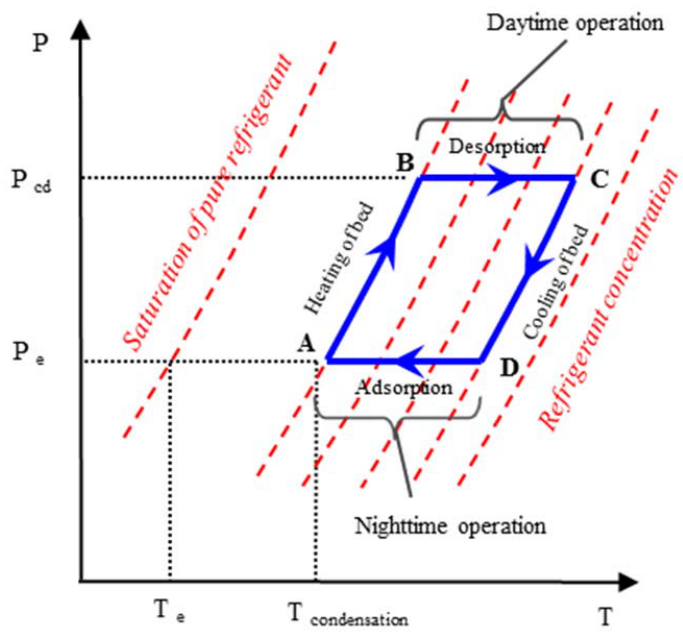
Figure 5. Ideal adsorption cycle (the Duhring